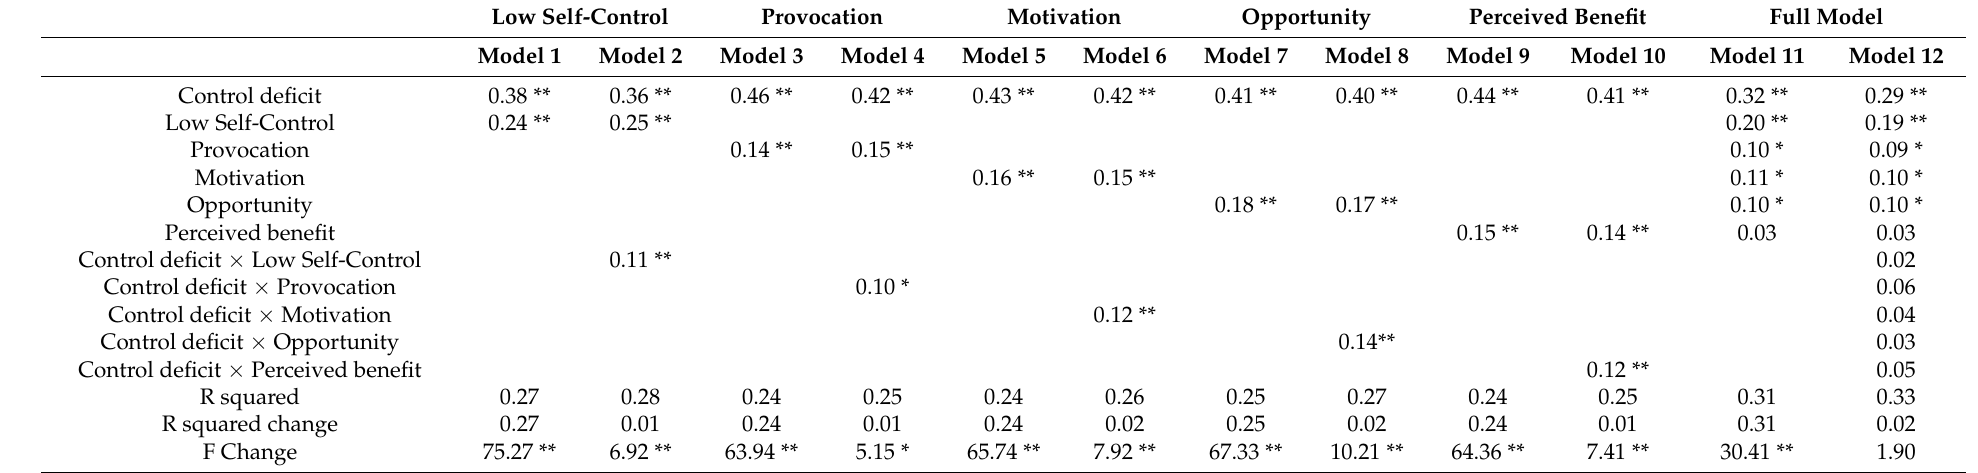
Table 3. Results for interaction analyses predicting athletes’ playing through pain and injury ( n =